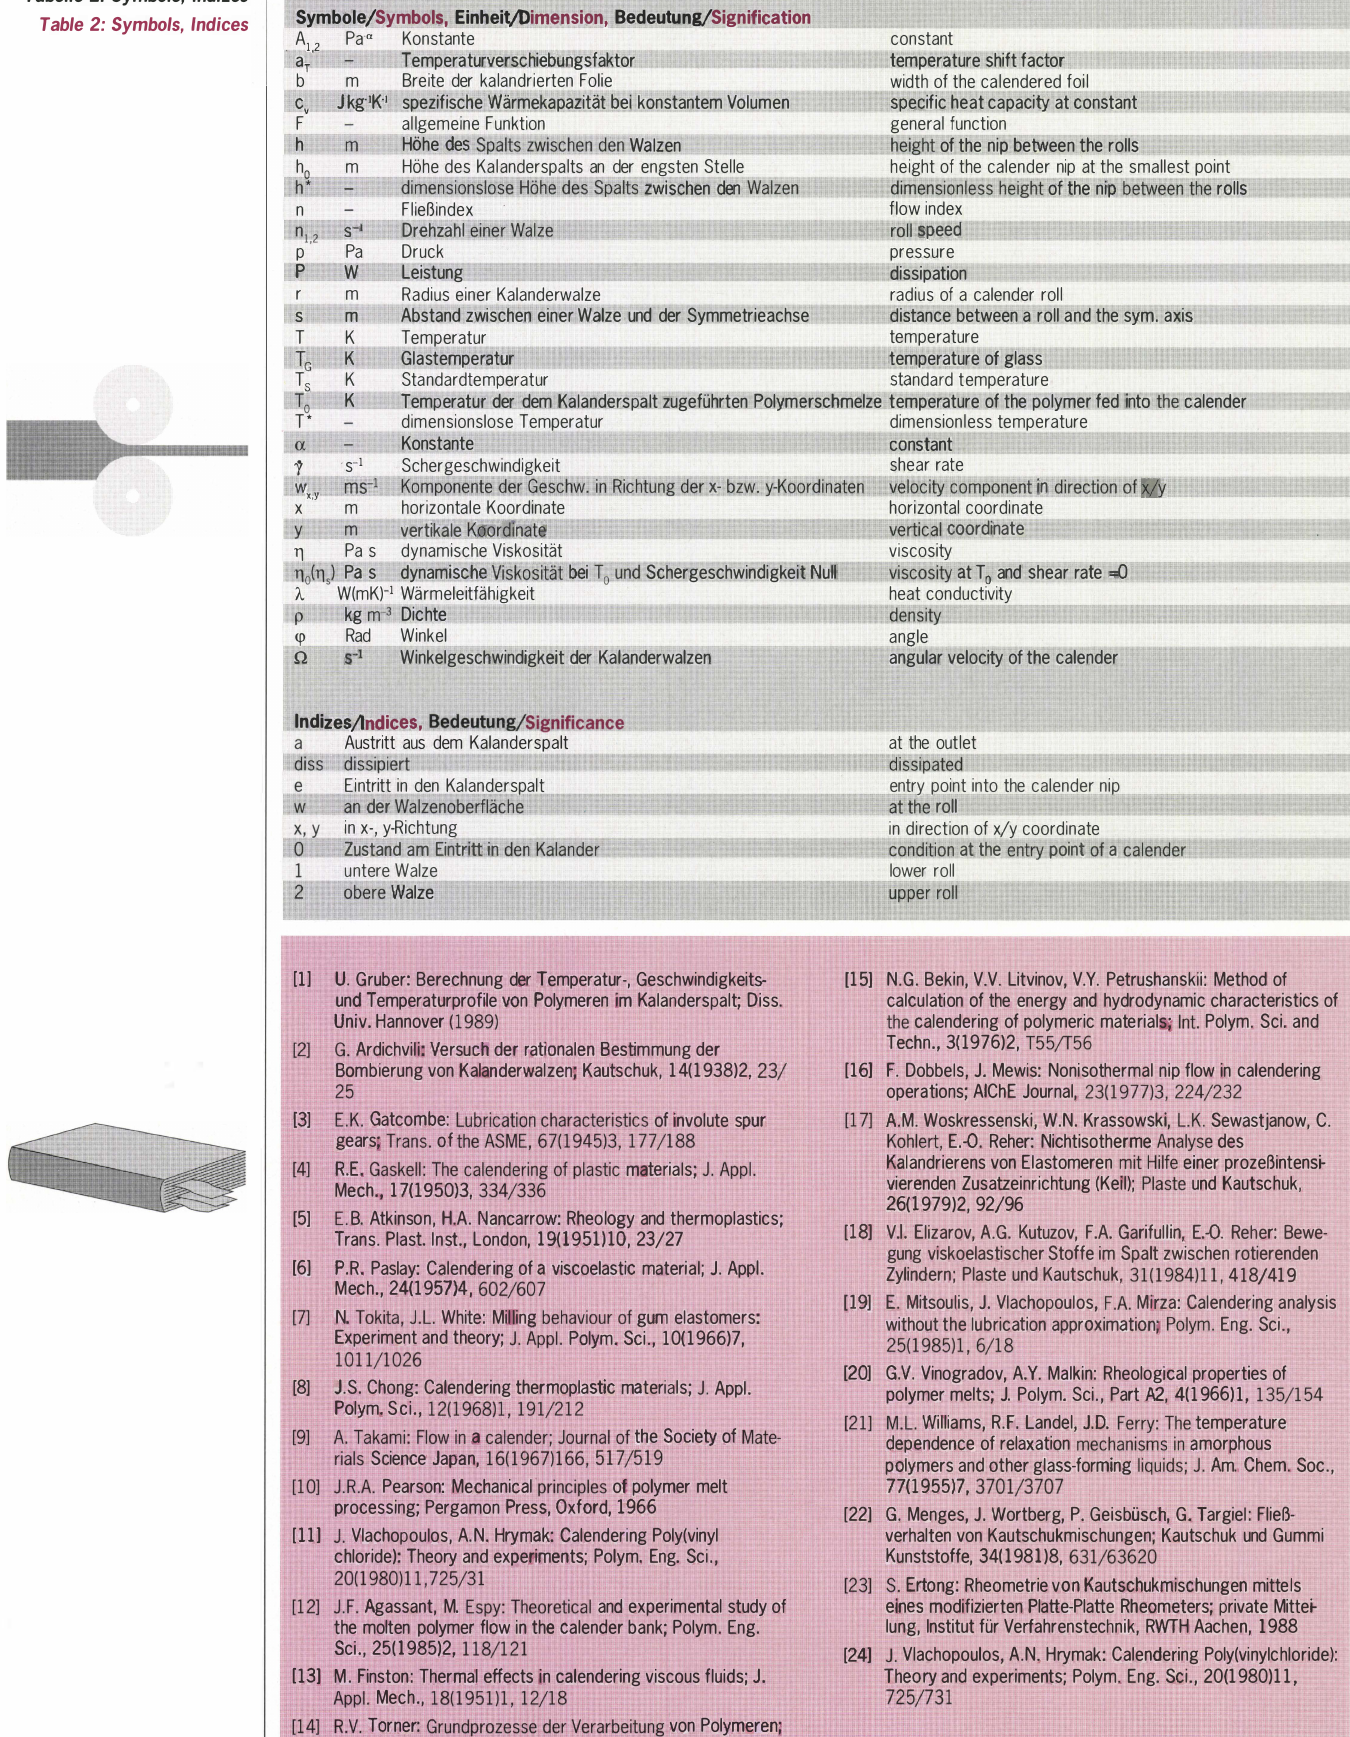
Symbole/Symbols, Einheit/l)imension, Bedeutung/Signification